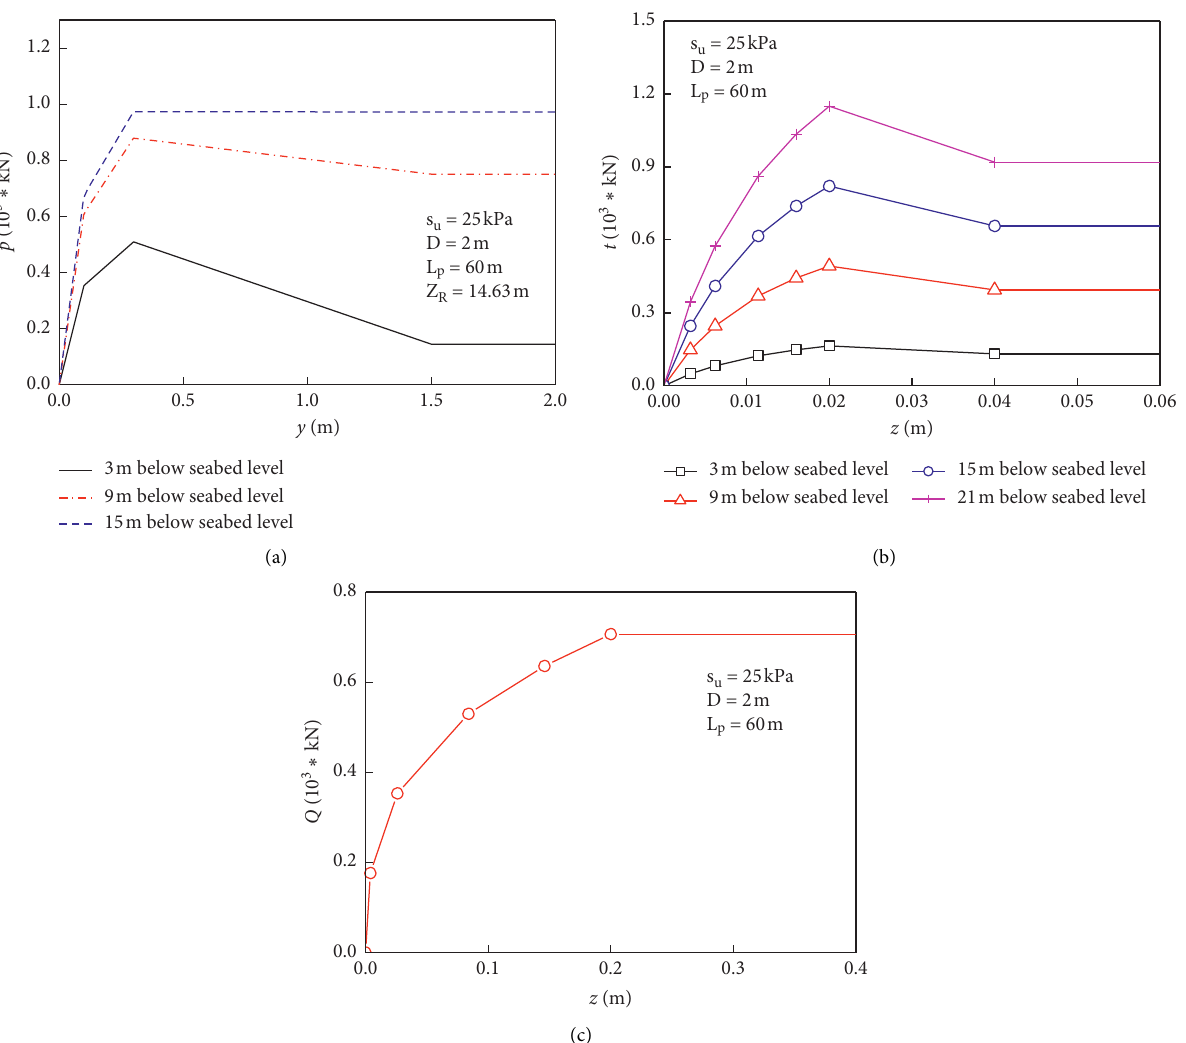
Figure 6: Typical plots of nonlinear springs: (a) p - y curve; (b) t - z curve; (c) Q - z